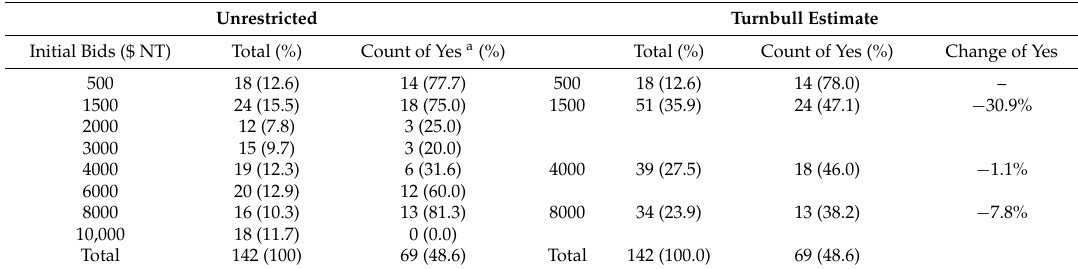
Table 4. Response ratings across the 1st and 2nd bids.